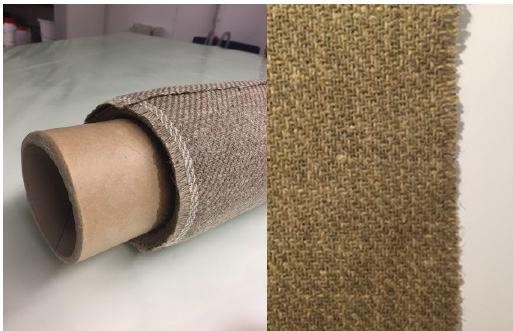
Figure 1. Flax fabric (area density of 550 g m −2 , 7 yarn threads per cm in fabric warp and weft direction).